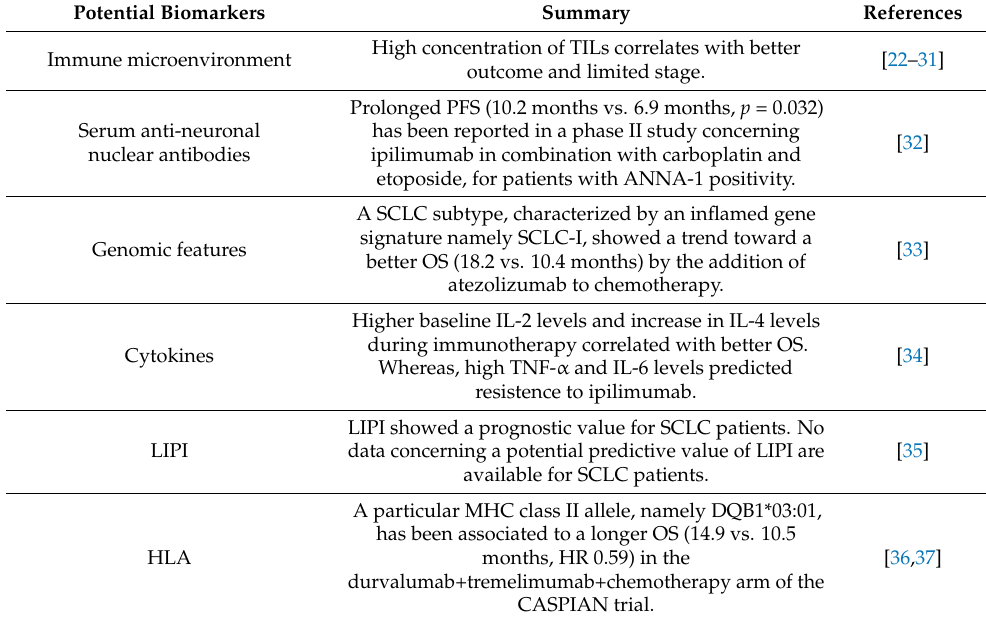
Table 3. Other potential